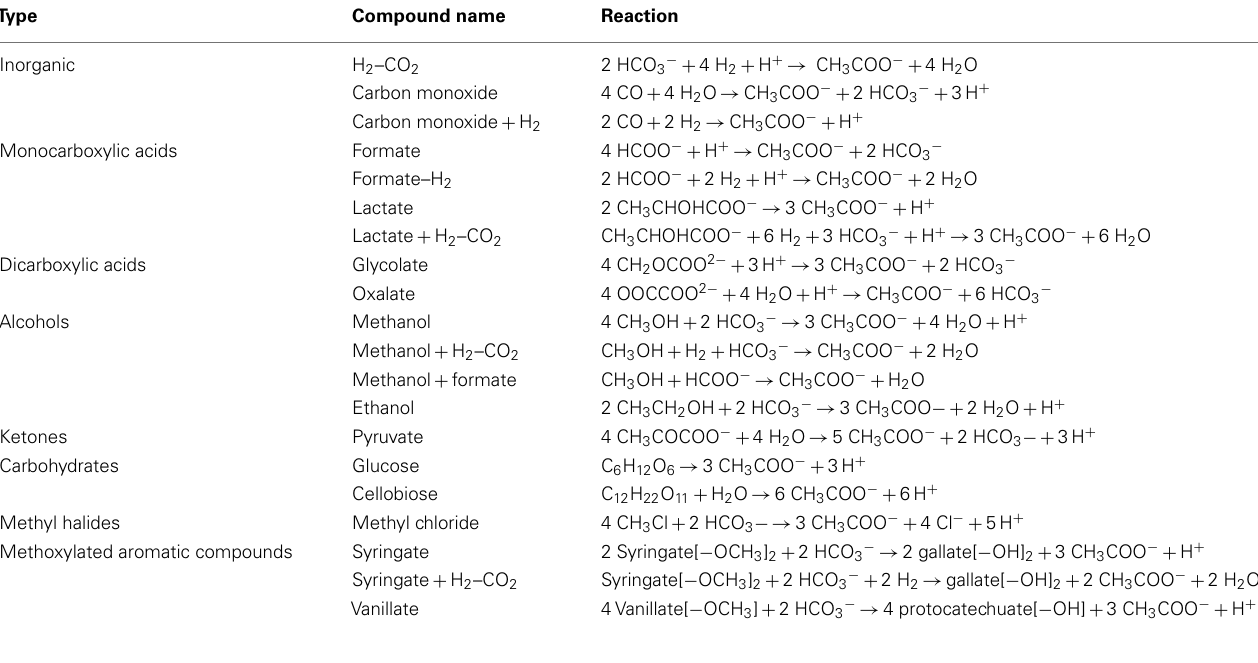
Table 1 | Overview of acetogenesis reactions examined in this study (from Drake et al.,